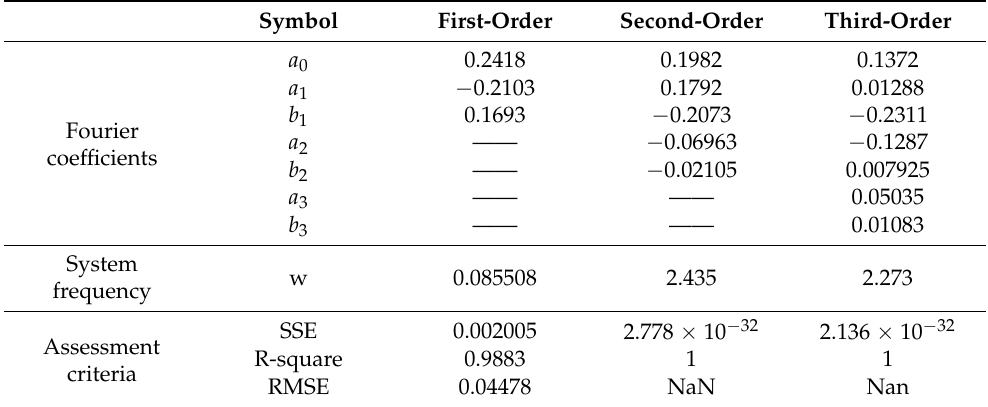
Table 7. Fourier coefficients and different types of fitting errors considering various orders of Fourier series for stress leveling of 20